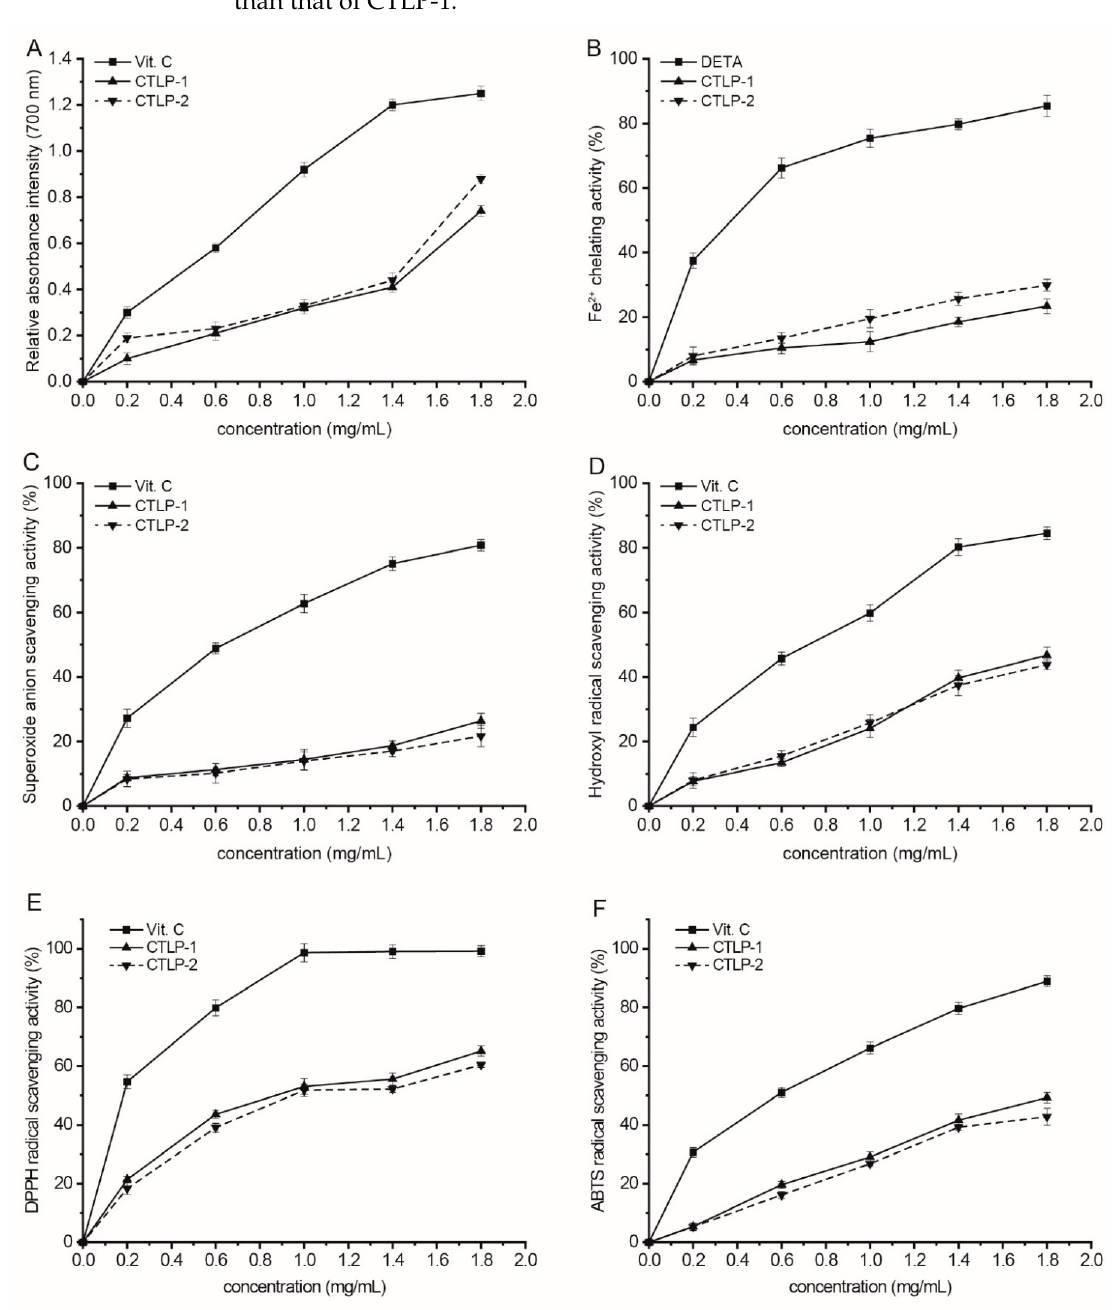
Figure 8. Antioxidant activities of CTLP-1 and CTLP-2. ( A ) reducing power; ( B ) Fe 2+ chelating activity; ( C ) superoxide anion scavenging activity; ( D ) hydroxyl radical scavenging activity; ( E ) DPPH radical scavenging activity; and ( F ) ABTS radical scavenging